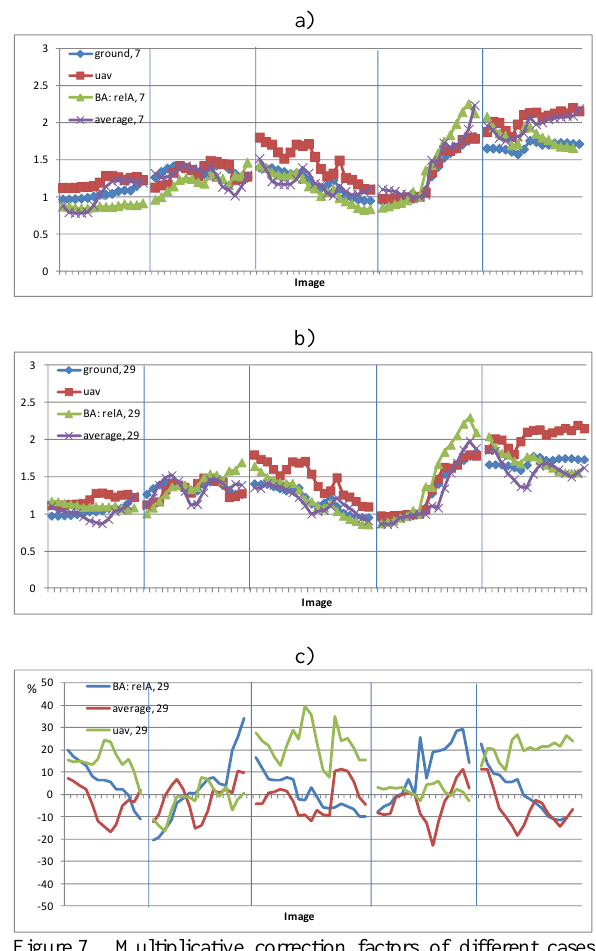
Figure 7. Multiplicative correction factors of different cases (see Section 3.4) for layers a) 7 and b) 29. c) Relative differences of different correction factors to correction factor based on ground irradiance measurement in layer 29 (in %).